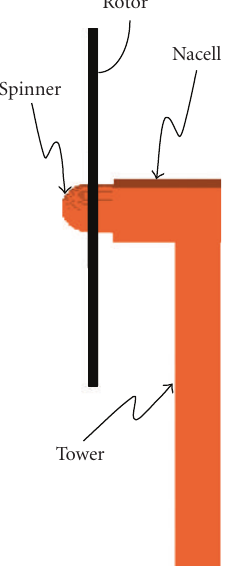
Figure 4: Enlarged view of